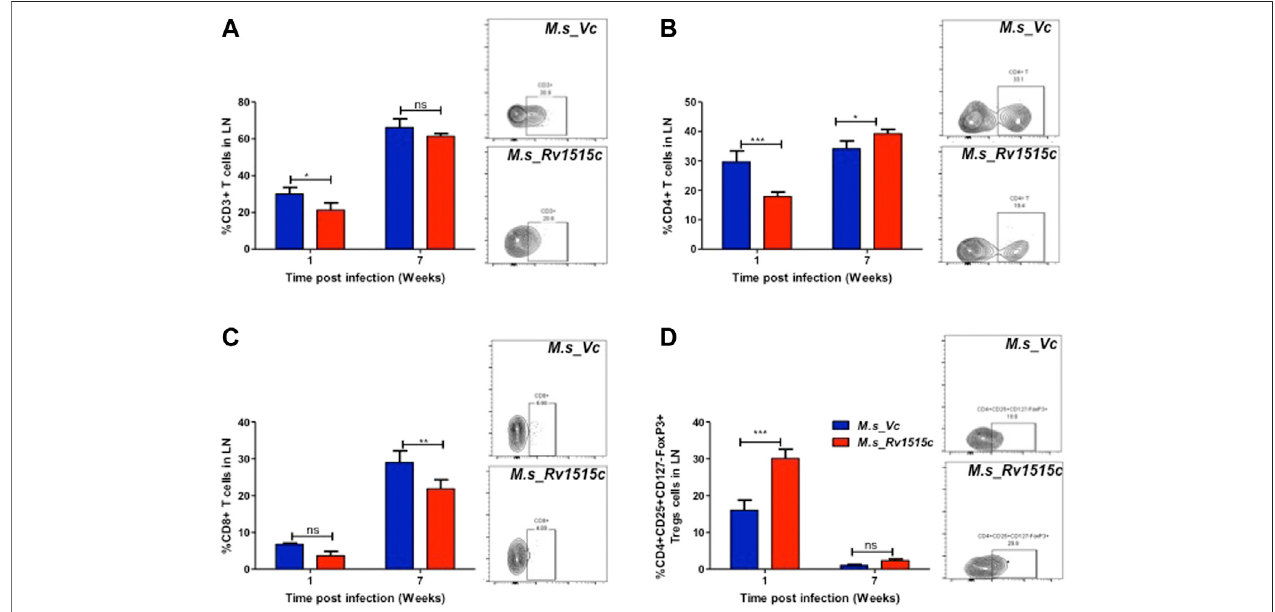
FIGURE 8 | Rv1515c suppresses T effector response via upregulation of immunosuppressive Tregs. C57BL/6 female mice ( n = 6) were infected intraperitoneally with M.s _Rv1515cand M.s _Vc. After1and 7 weekspostinfection, lymphnodeswereextracted andsinglecellsuspensionswerestainedwithantibodiestodetectthe percentofTcellsub-populations. (A) CD3 + Tcells, (B) CD4 + Tcells, (C) CD8 + Tcells, (D) TregcellsexpressingCD4 + CD25 + CD127 − FoxP3 + .Inset:representativedot-plot of fl owcytometrydatafor24 htimepoint.Dataarerepresentedasmean±SDandstatisticalanalysiswasperformedusingtwo-wayANOVAfollowedbyBonferroni test. * p < 0.05, ** p < 0.01, *** p < 0.001, ns- nonsigni fi